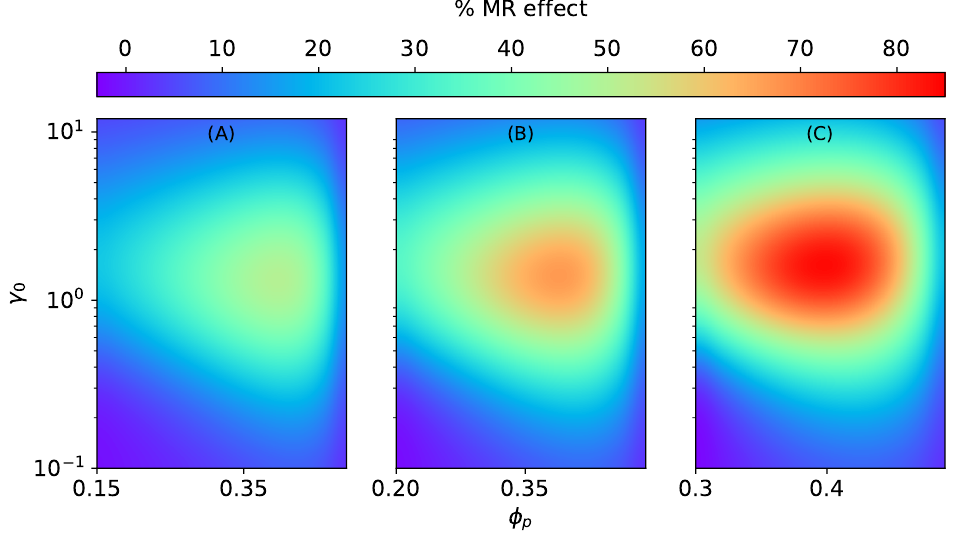
(cid:16) (cid:17) K (cid:107) of an ellipsoidal MAE with SC microstructure SC